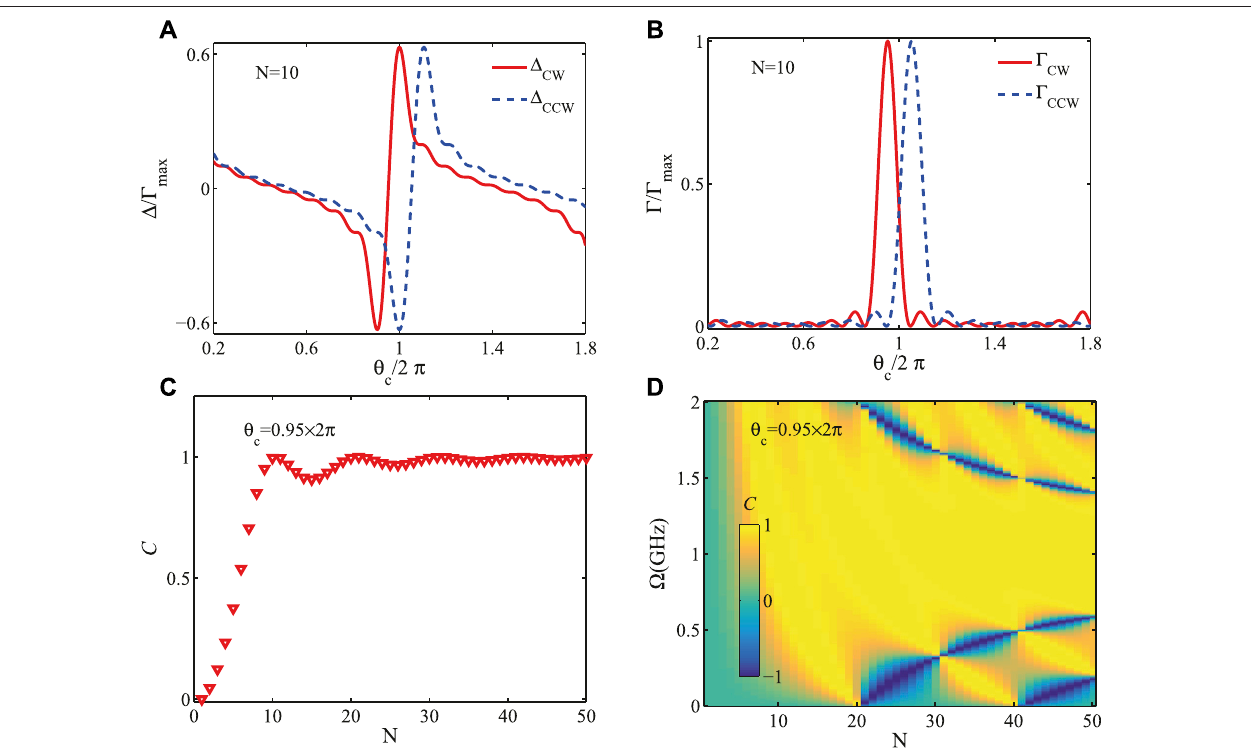
FIGURE2| (Color online)Thefrequencyshifts Δ j (A) and thedecayrates Γ j (B) fortheCW andCCW modesversusphase θ c = ω c d / c for N =10and Ω =0.97 GHz. The maximum decay rate Γ cw is used for normalization. (C) The chiral factor C changes with number of coupling points N . (D) The chiral factor C versus N and rotation speed Ω are plotted. Other parameters are set as: λ = 1,550 nm, R = 4.73 mm, n = 1.4, and κ c =